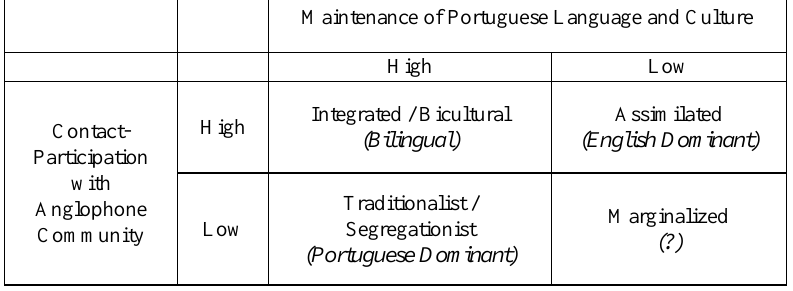
Figure 10: Matrix of Lusophone Maintenance vs. Contact-Participation with the Dominant Anglophone Community (after Berry